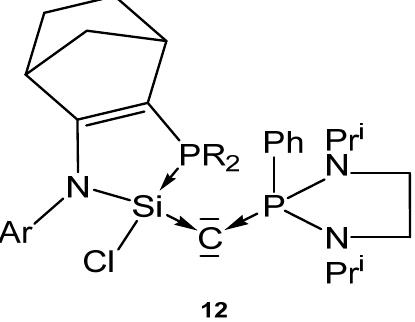
Figure 15. Carbone complex reported by Kato et al. [99].